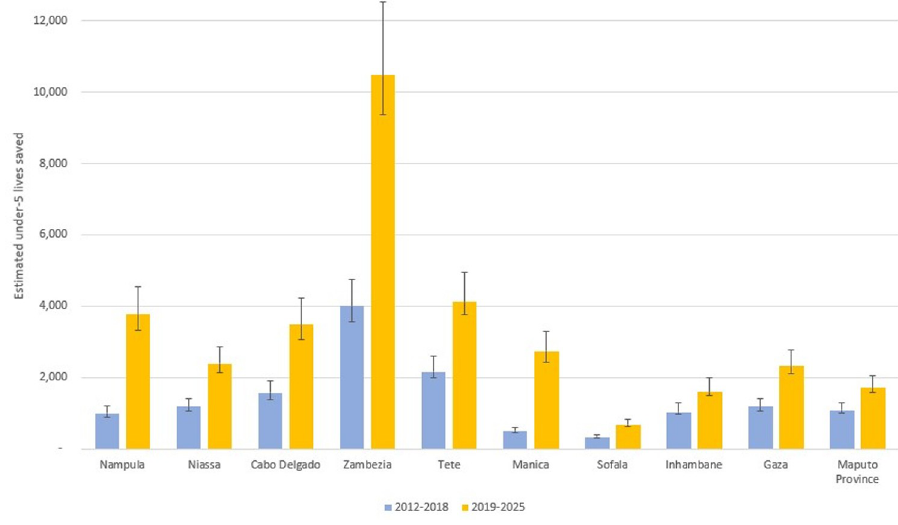
Fig 3. Estimated number of under-5 lives saved by province in Mozambique from 2012 to 2018 based on changes in household ITN ownership coverage.